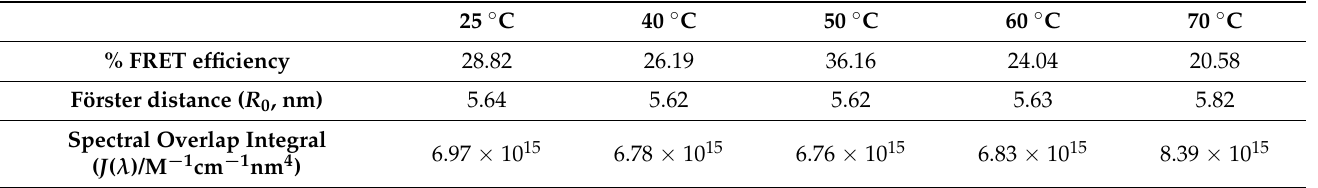
Table 2. FRET parameters: FRET efficiency, theoretical Förster distance, and spectral overlap integral for a range of